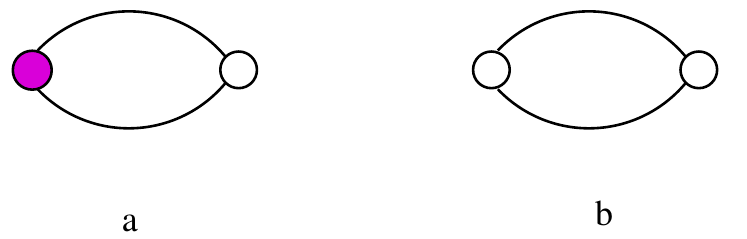
Figure 1 . (a) Monopole-antimonopole stringy meson. (b) Monopole \necklace" baryon for U(2) gauge theory. Open and closed circles denote monopoles and antimonopole